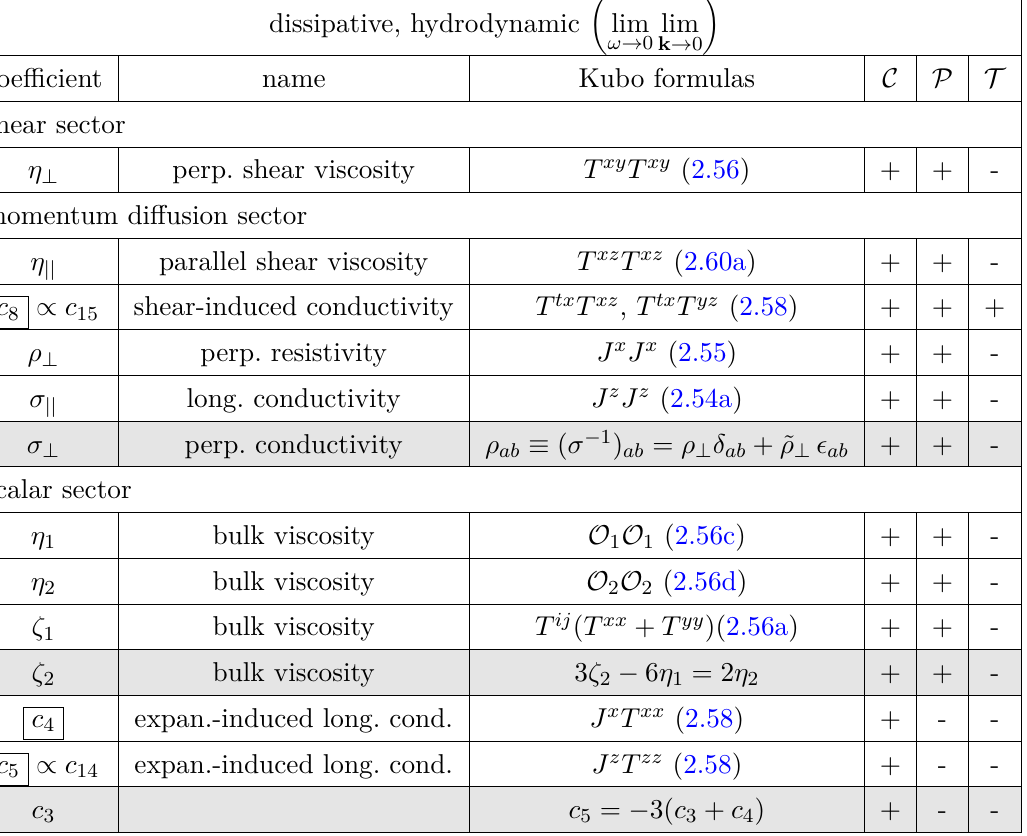
Table 5 . Independent dissipative hydrodynamic transport coefficients in a charged chiral thermal plasma subjected to a strong U(1) magnetic field. Similar to table 4. Abbreviations: perpendicular A (perp.), longitudinal (long.), conductivity (cond.), expansion (expan.). Gray shaded rows display relation of dependent transport coefficients to the set of independent transport coefficients. Boxed quantities are novel in this